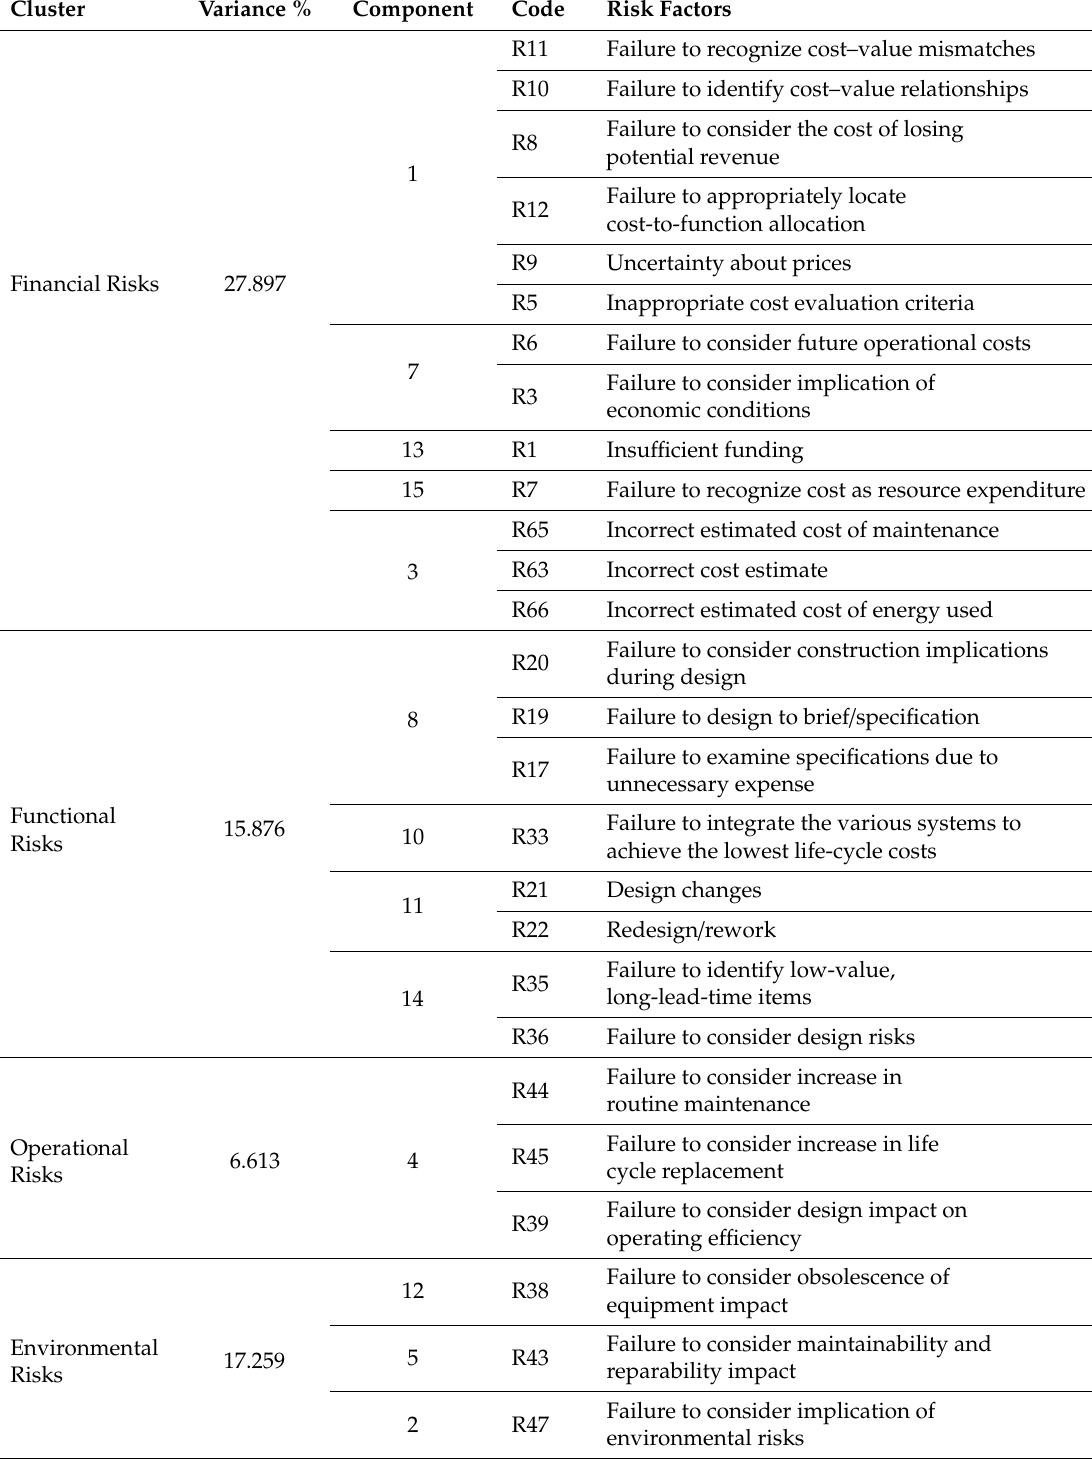
Table 5. Factor reduction for the risk factors: five new